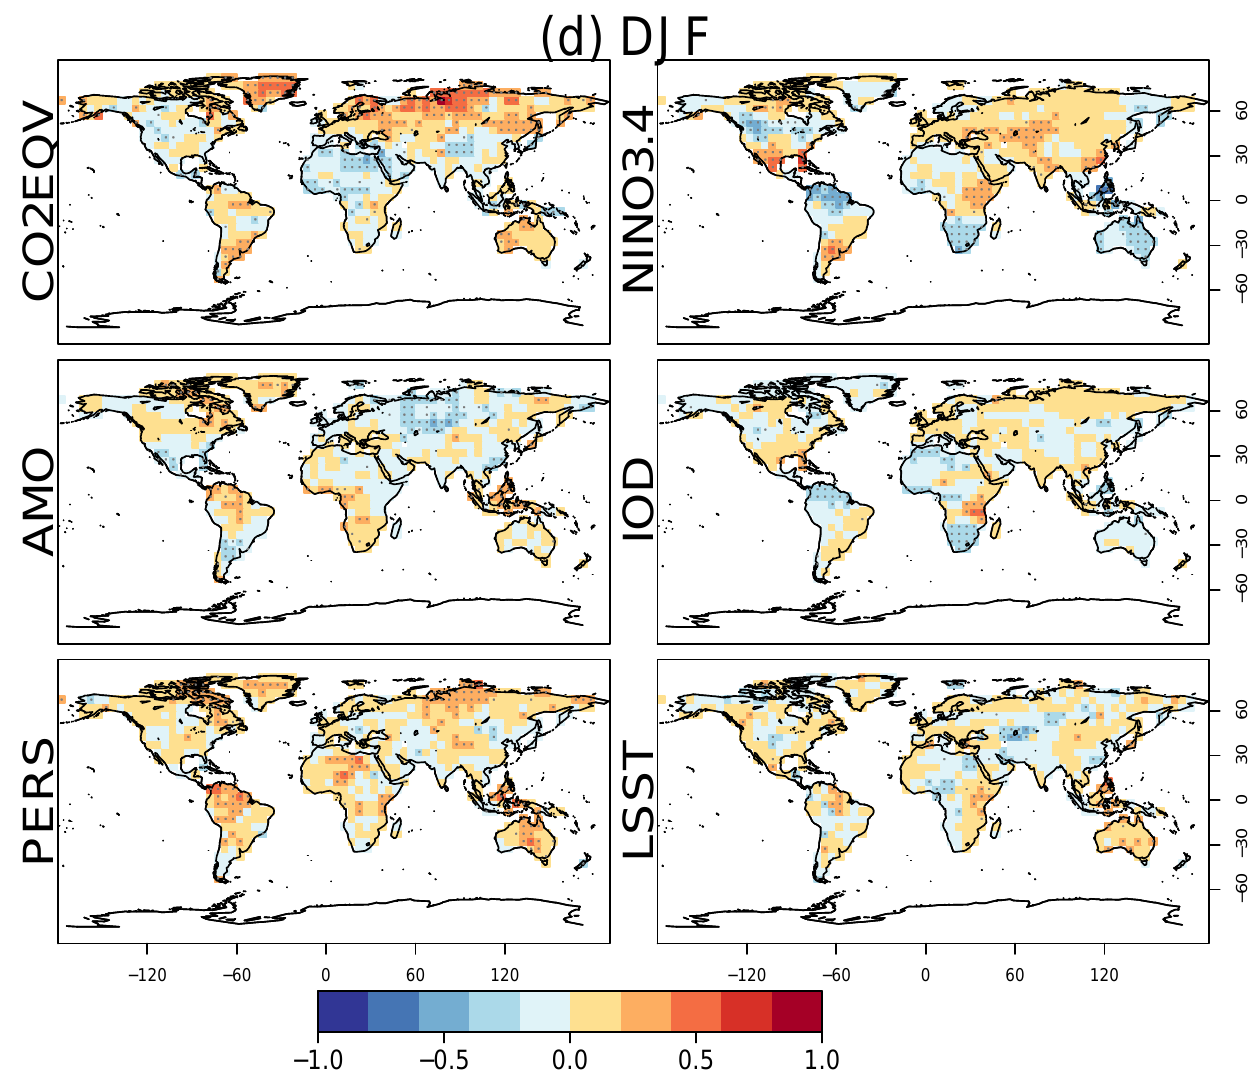
Figure 2. Correlation between PREC and the set of predictors (1961–2013) for (a) MAM, (b) JJA, (c) SON, and (d) DJF. As in Fig. 1, correlation with CO2EQV is shown in the top left panel; subsequent panels show correlation between predictand–predictor pairs following removal of the CO2EQV trend. Stippling is used to indicate significance at the 95% level.